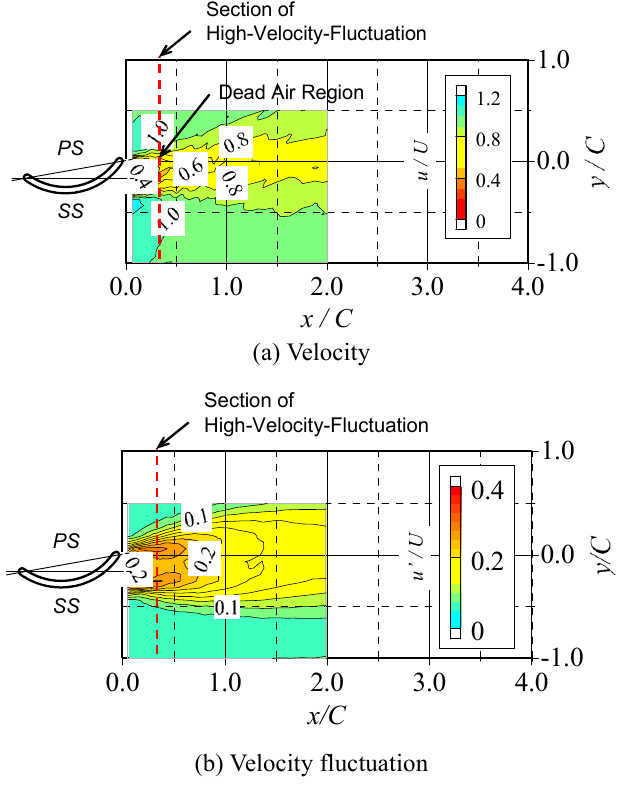
Fig.10 Contour of the velocity and the velocity fluctuation of the arc blade in the